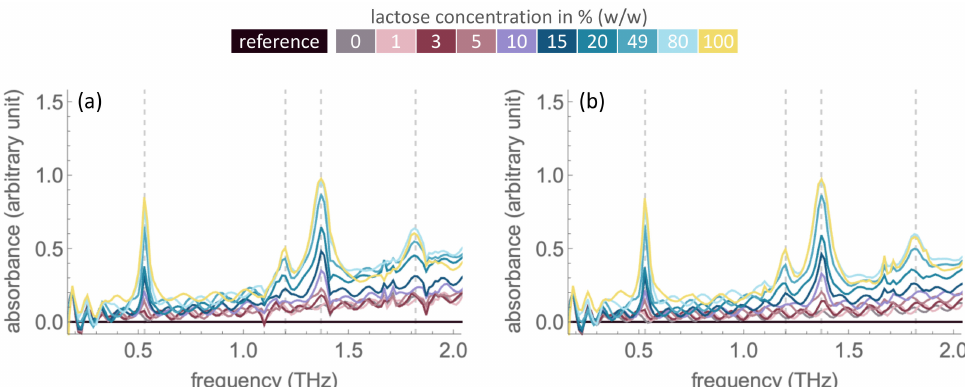
Figure 1. THz absorption spectra of α -lactose monohydrate at varying concentrations under ( a ) ambient condition ( ≈ 37% RH) and ( b ) nitrogen-rich ( ≤ 7% RH) atmosphere. Frequencies of absorption peaks (0.53 THz, 1.20 THz, 1.37 THz, 1.82 THz) are signified by vertical dashed lines. Ab- sorbance values (arbitrary unit) are the ratio between the intensity of the substance and the reference, as described in Equation (1) under Section